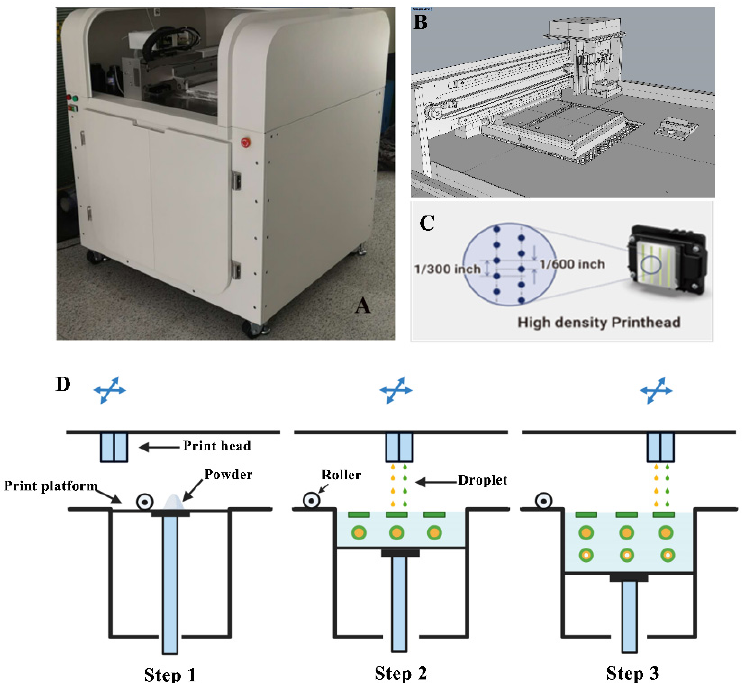
Figure 2. Diagram of the self-developed binder jet 3D printer. ( A ): Physical view of the device; ( B ): Print platform; ( C ): Print head; ( D ): Print process diagram.